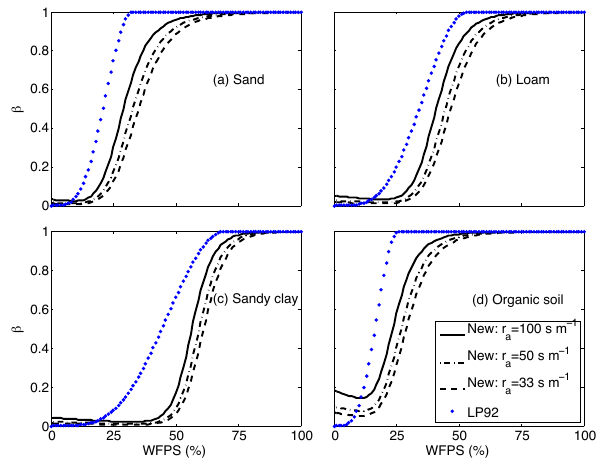
Figure 4 . Sensitivity of the calculated soil evaporation efficiency to WFPS and the 2 Fig. 4. Sensitivity of the calculated soil evaporation efficiency to WFPS and the atmospheric conductance for the four different soils atmospheric conductance for the four different soils listed in Table 3. The four panels are, 3 listed in Table 3. The four panels are, respectively, (a) sand, (b) respectively, (a) Sand, (b) Loam, (c) Sandy loam, and (d) Organic soil. For all cases, we 4 loam, (c) sandy loam, and (d) organic soil. For all cases, we as- sumed that D 0 = 2 . 4 × 10 − 5 m 2 s − 1 and 1 z assumed that D 0 = 2.4 ! 10 " 5 m 2 s -1 and ! z 1 = 1.75 cm (as it is used in CLM4). 5 in CLM4).